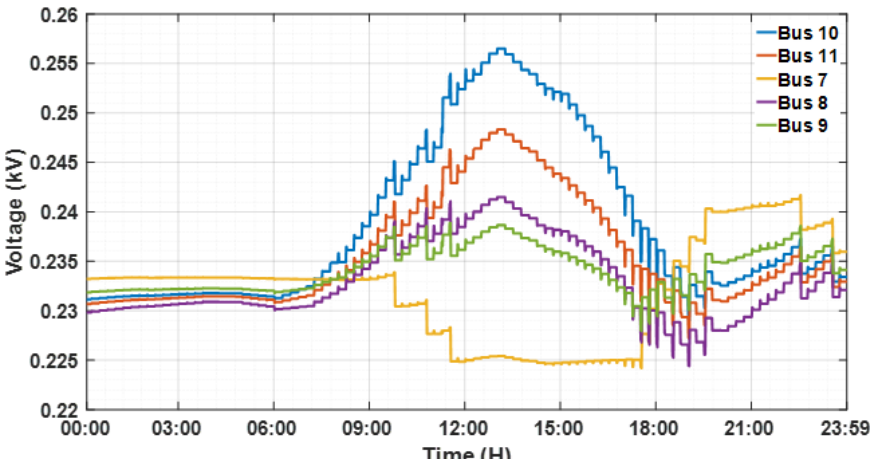
Figure 14. Voltage profiles with CVC.